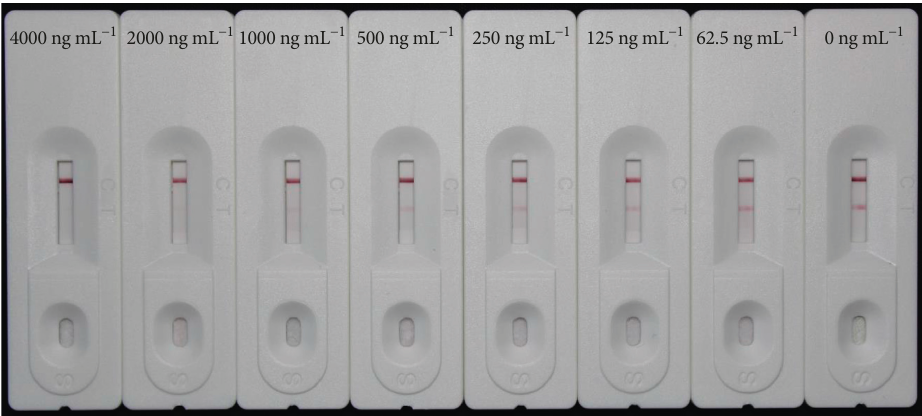
Figure 5: CGIC strips showing color changes corresponding to the concentrations of emodin. The cutoff value for emodin was 2000ng mL − 1 .